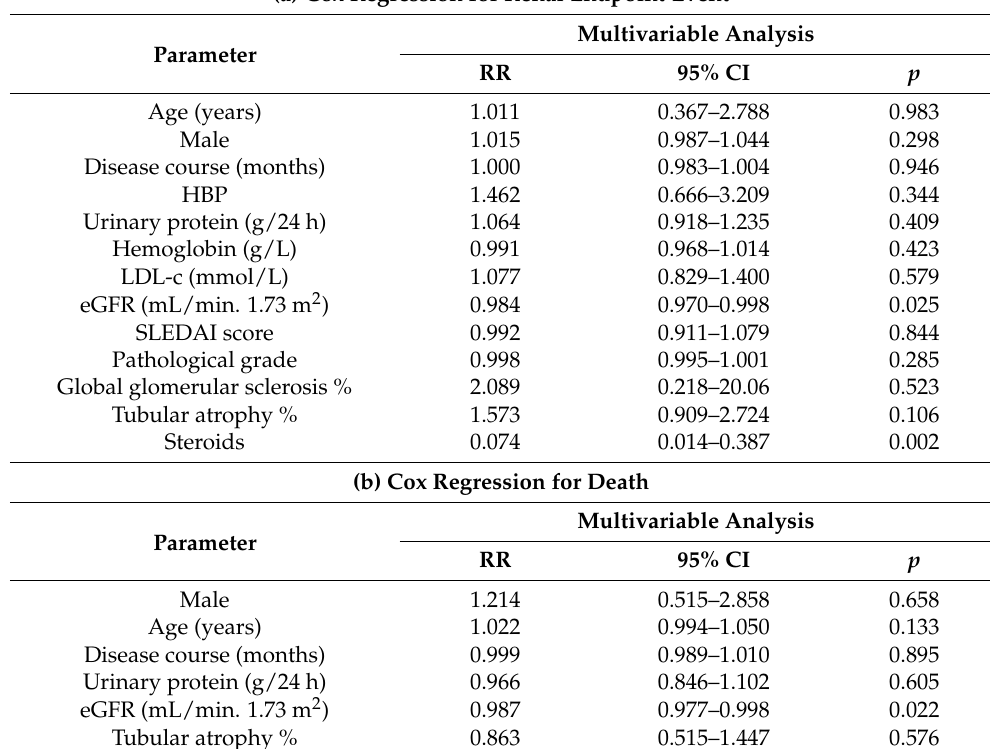
Table 4. Factors influencing clinical outcomes among LN(lupus nephritis) patients with hyperuricemia. (a) Cox Regression for Renal Endpoint